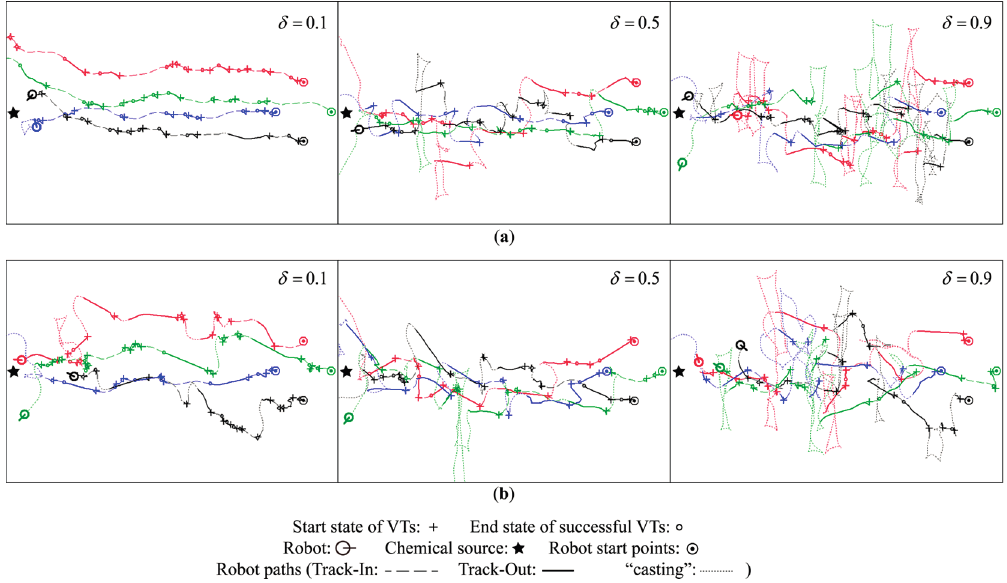
Figure 10. Comparison of the robot trajectories obtained by setting different values of δ